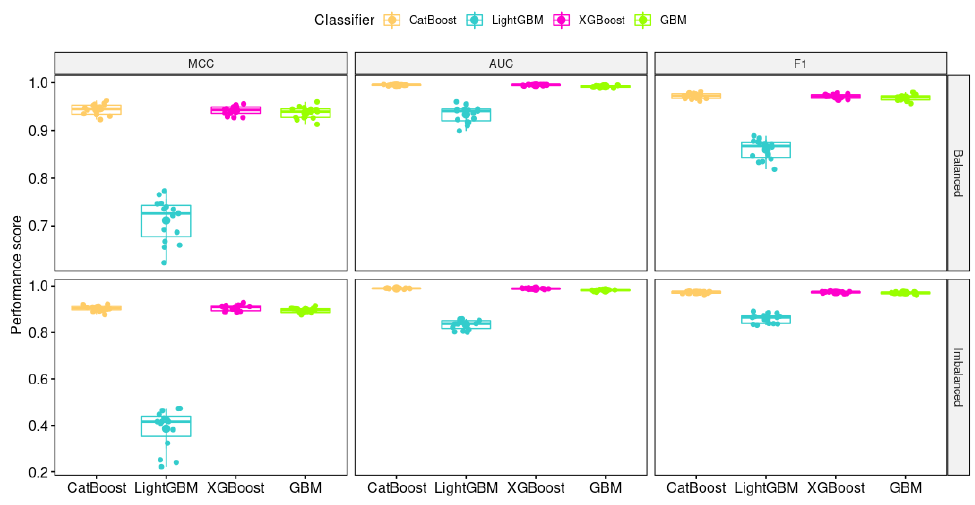
Figure 2. The skewness and spread of algorithms’ performance over two distinct